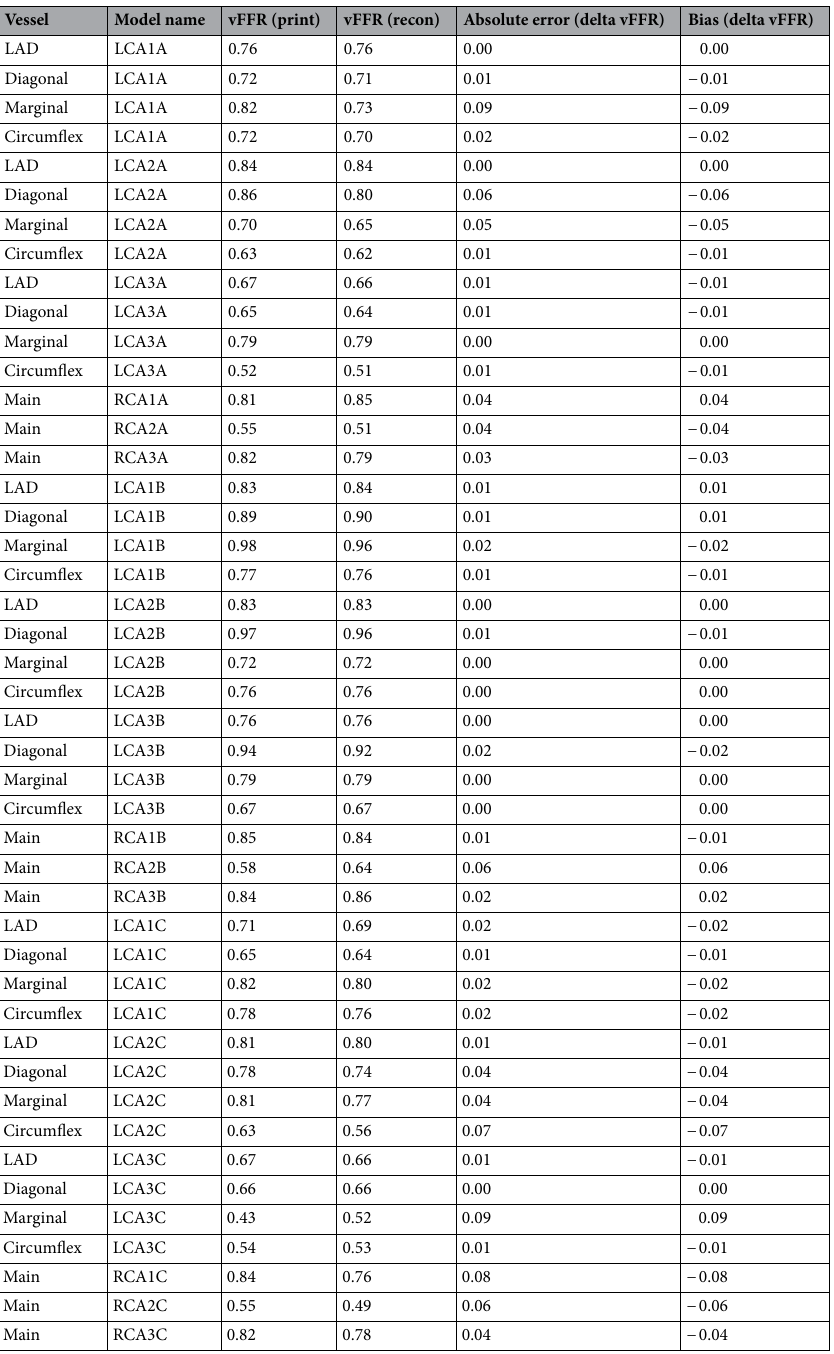
Table 3. Per-vessel vFFR measurements for reconstructed and reference meshes. The observed error in physiological simulation for 3D reconstructed vessels when compared to their reference (print mesh) counterparts is also